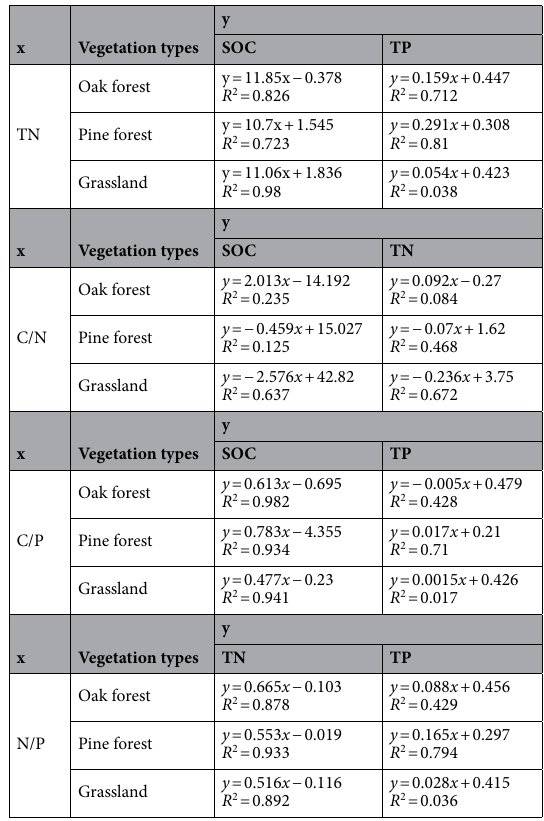
Table 1. Correlation analysis of soil SOC. TN, TP and stoichiometry ratios in different vegetation types ( p <